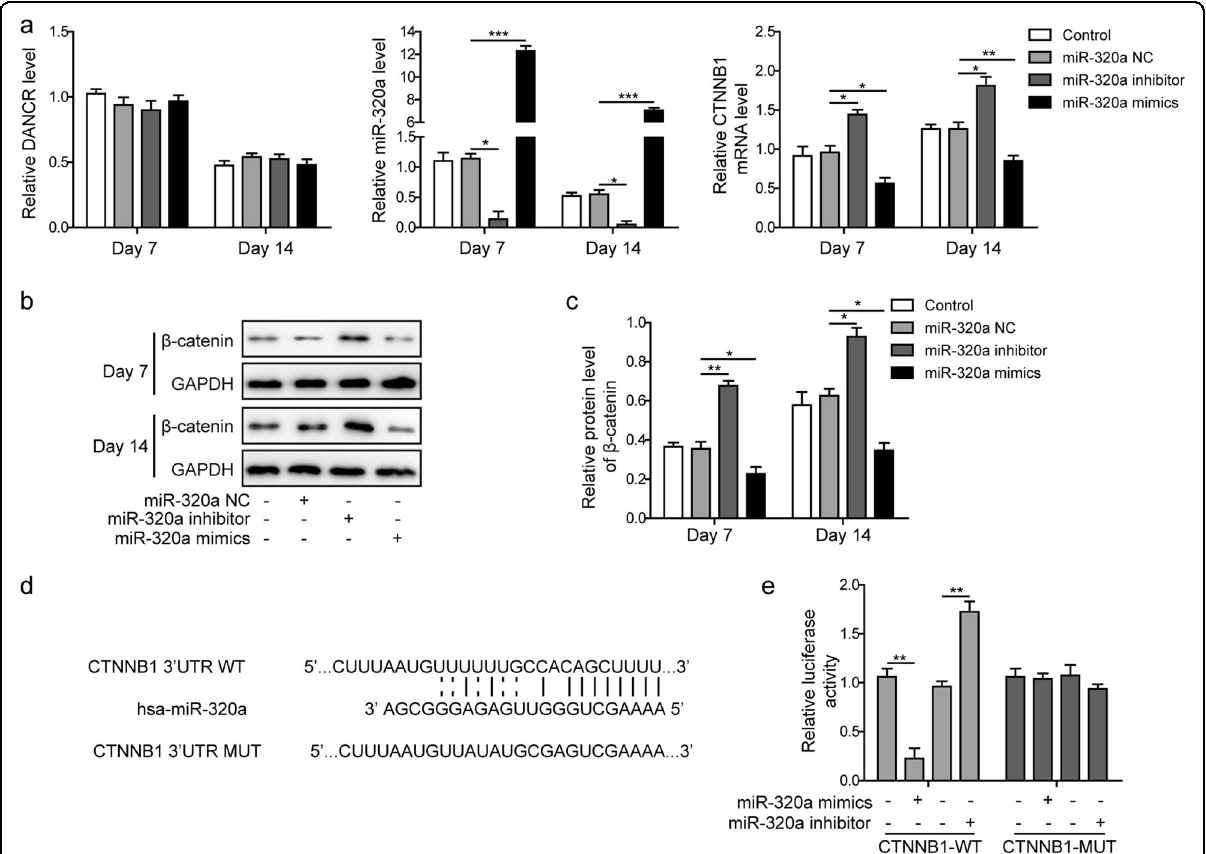
Fig. 3 CTNNB1 was directly regulated by miR-320a during osteogenic differentiation. a Relative expression levels of DANCR, miR-320a, and CTNNB1 were assessed by qRT-PCR. b The impact of miR-320a on β -catenin expression was veri fi ed by western blot analysis. c Quantitative analysis of β -catenin protein expression in b . d The potential binding sites between CTNNB1 and miR-320a were identi fi ed using StarBase and TargetScan web tools, and a corresponding mutant construct (CTNNB1-MUT) with the indicated sequence was generated. e CTNNB1 wild-type (CTNNB1-WT) and CTNNB1-MUT were cloned into a luciferase reporter vector, and BMSCs were cotransfected with lentivirus encoding miR-320a inhibitor or miR-320a mimics. All experiments were conducted independently at least three times. * P < 0.05, ** P < 0.01, and *** P <